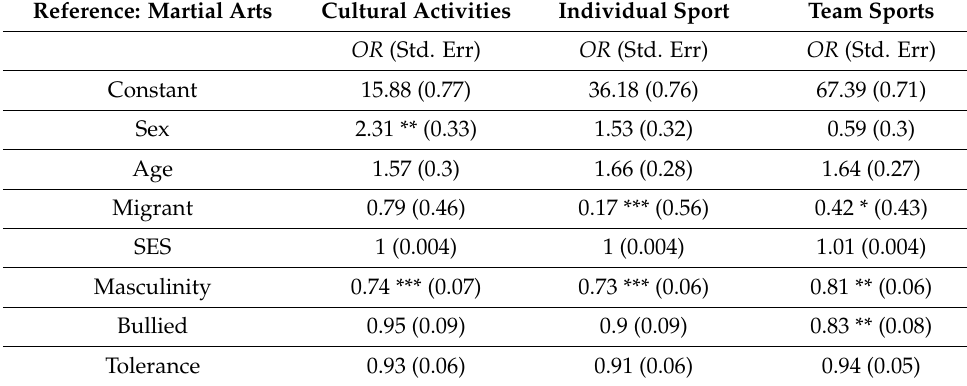
Table 3. Youths’ demographics, masculinity, tolerance, and levels of being bullied. Reference: Martial